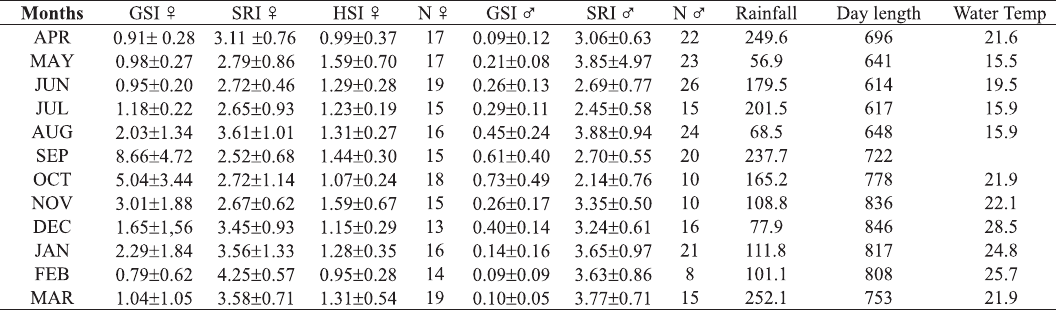
Fig. 2. Frequency of occurrence of gonadal maturation stages for females (a) and males (b) of Bryconamericus iheringii from rio Vacacaí, RS, Brazil, from April 2001 through March 2002. IMT = immature; MTG = maturing; MAT = mature; SPW = spawning; SPT = spent. Table 1. Monthly variation in the mean values of GSI (gonadosomatic index), SRI (stomach repletion index), HSI (hepatosomatic index) (± SD) and number of individuals (N) of females and males of Bryconamericus iheringii from rio Vacacaí, RS, Brazil,